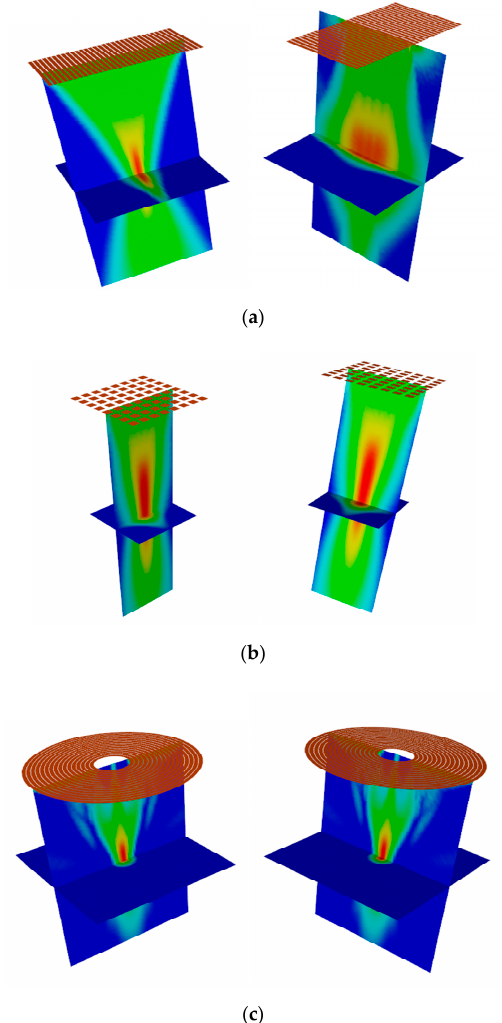
Figure 1. The focus acoustic field of di ff erent ultrasonic array transducers in the monolayer medium: ( a ) linear array, ( b ) matrix array, ( c ) annular array.